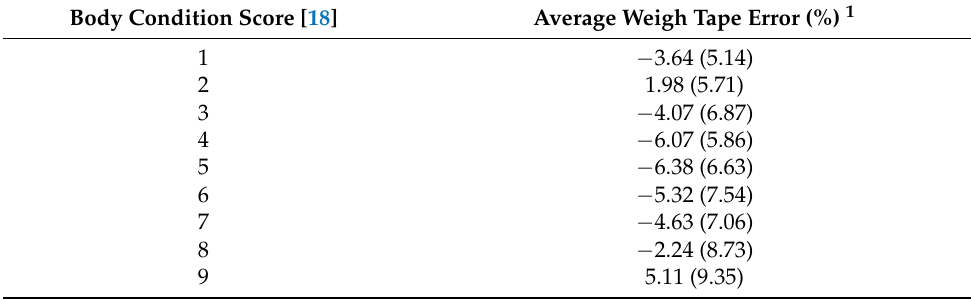
Table 2. Average weigh tape error for each body condition score unit.